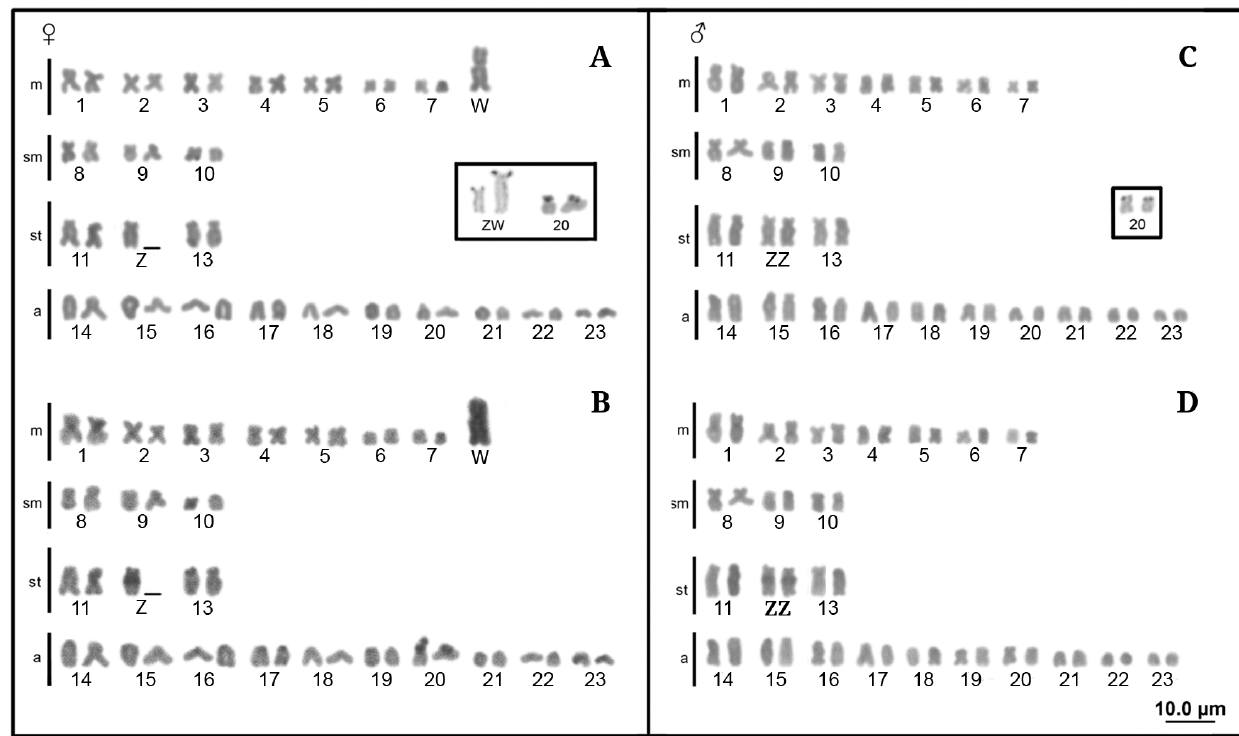
FIGURE 1 | Centromochlus heckelii female (A, B) and male (C, D) karyotypes, stained with Giemsa (A, C) and after C-banding (B, D). Pairs with AgNORs, in